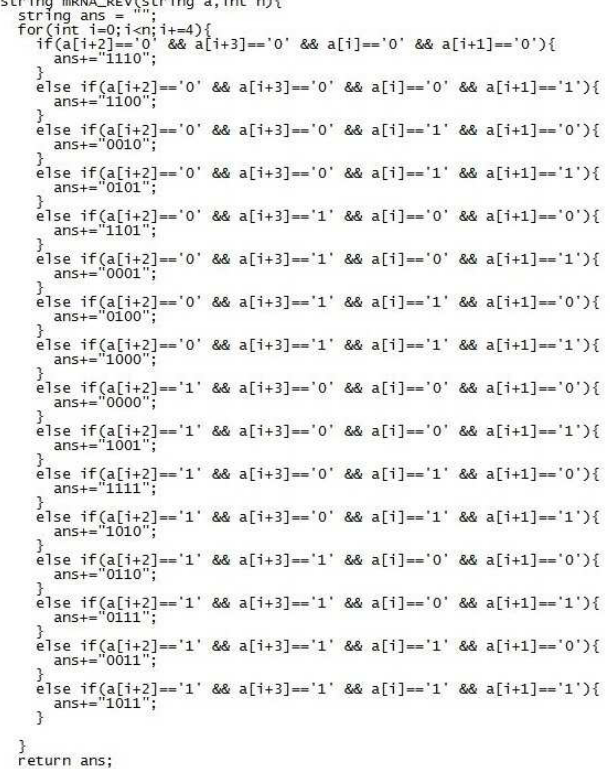
Figure A2. mRNA second letter and first letter.